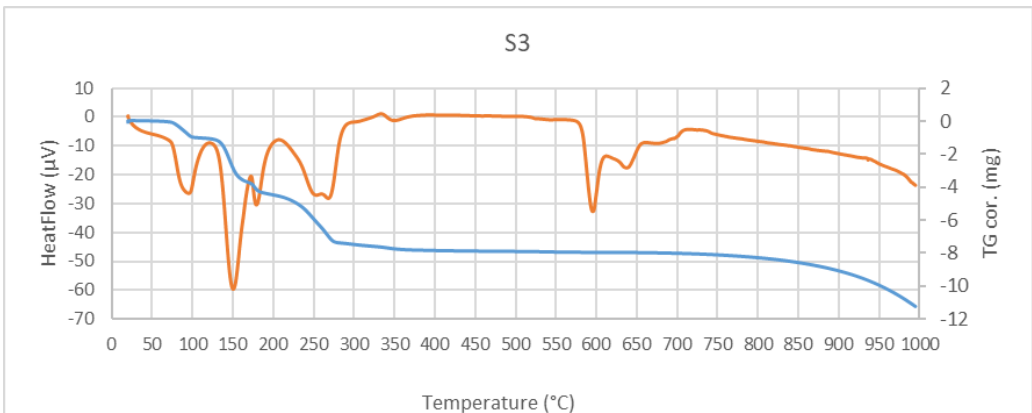
Figure 2. ( a – c ) Thermogravimetric data for samples S3 – S5. The peak at ~100 °C corresponds to the loss of water molecules physically adsorbed on the surface of the samples. Additionally, the loss of hydration water from the hexa- hydrite molecule is observed in this temperature range, as seen for samples S3 and S4 (Figure 2a,b). TG/DTA curves obtained for samples S3 – S5 and presented in Figure 2a-c show two major peaks at temperatures higher than 100 °C, which are typical of thermally modified gypsum. They indicate two overlapping thermal processes: the first one at ~150 °C can be interpreted as the partial dehydration of gypsum, leading to calcium sulfate hemihy-